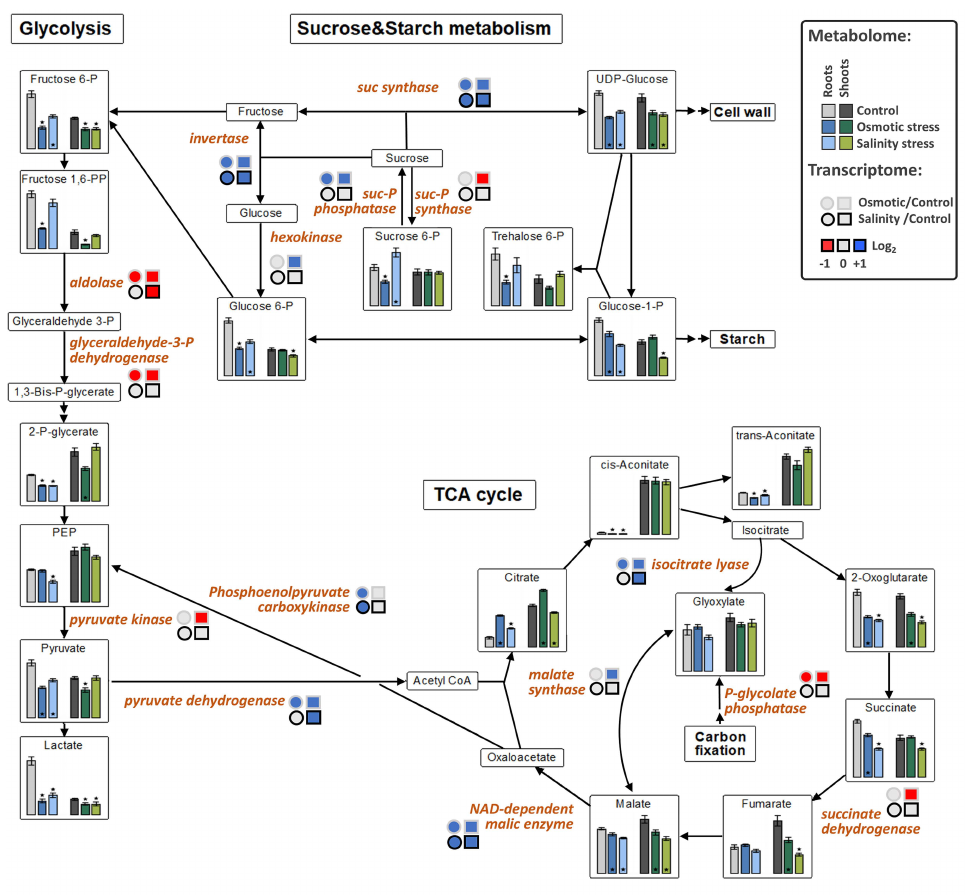
Figure 5. The e ff ect of osmotic and salinity stresses on the sugar and central metabolism and corresponding transcriptomic changes in roots and shoots of Hordeum marinum. Metabolic data, presented as bars, are means ± SE; n = 7. Significant di ff erences to control treatments at specified time points after excision are indicated by *, p < 0.05 (Wilcoxon, Mann-Whitney U-test). Up-regulated genes are labeled by blue, down-regulated by red